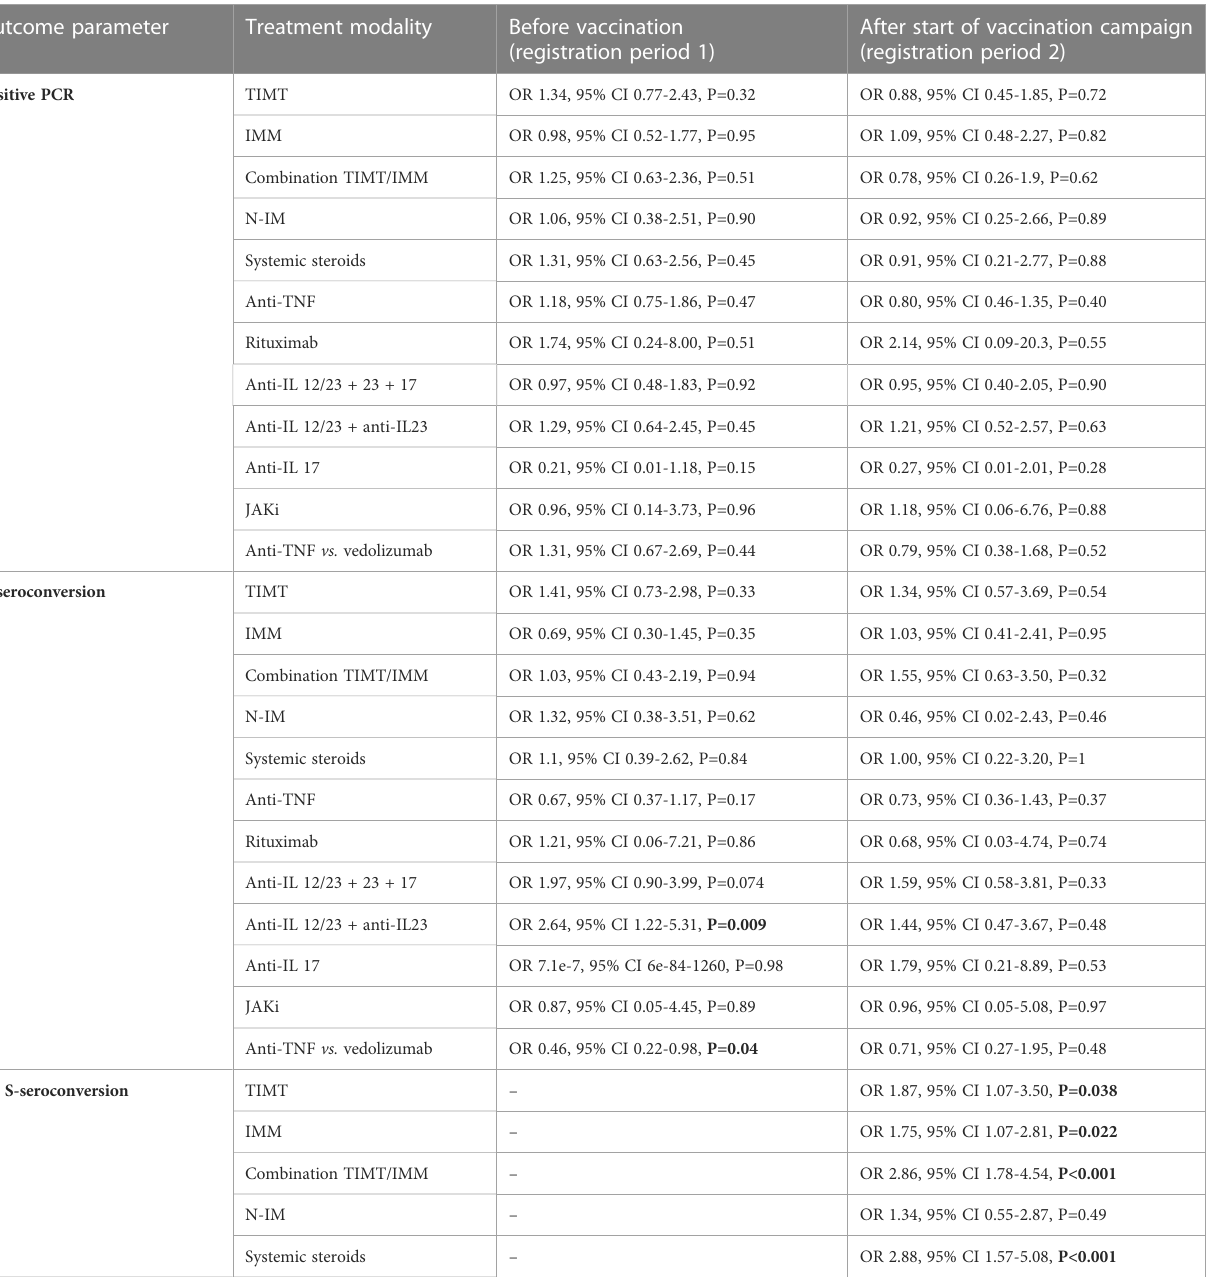
TABLE 2 Associations* between SARS-CoV-2 PCR/serology and IMID treatment modality. Outcome parameter Treatment